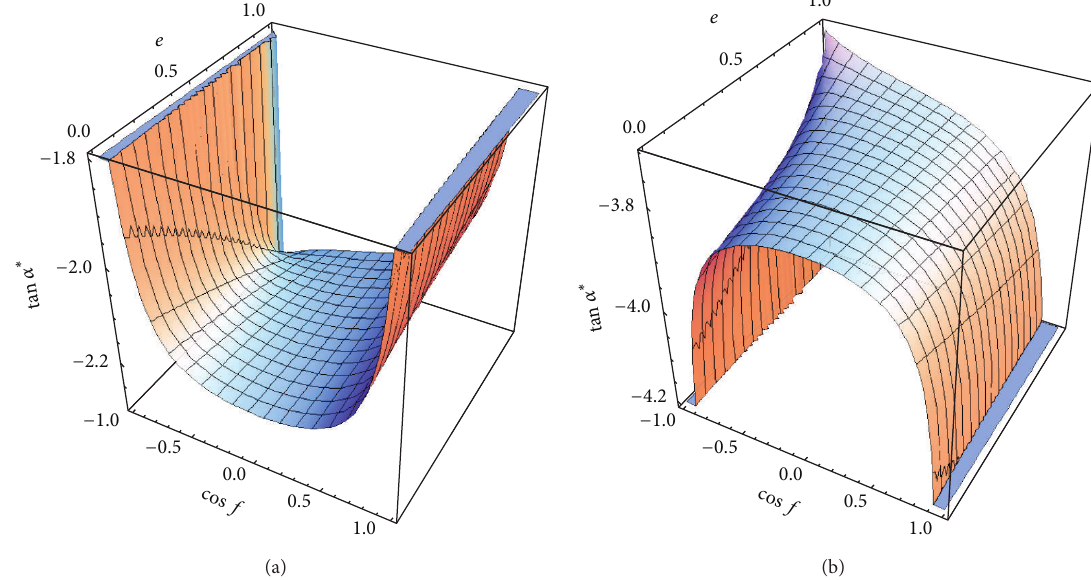
Figure 6: (a) The optimum cone angle that maximizes the rate of change of argument of perihelion when taking the positive sign in the numerator. (b) The optimum cone angle that maximizes the rate of change of argument of perihelion when taking the negative sign in the